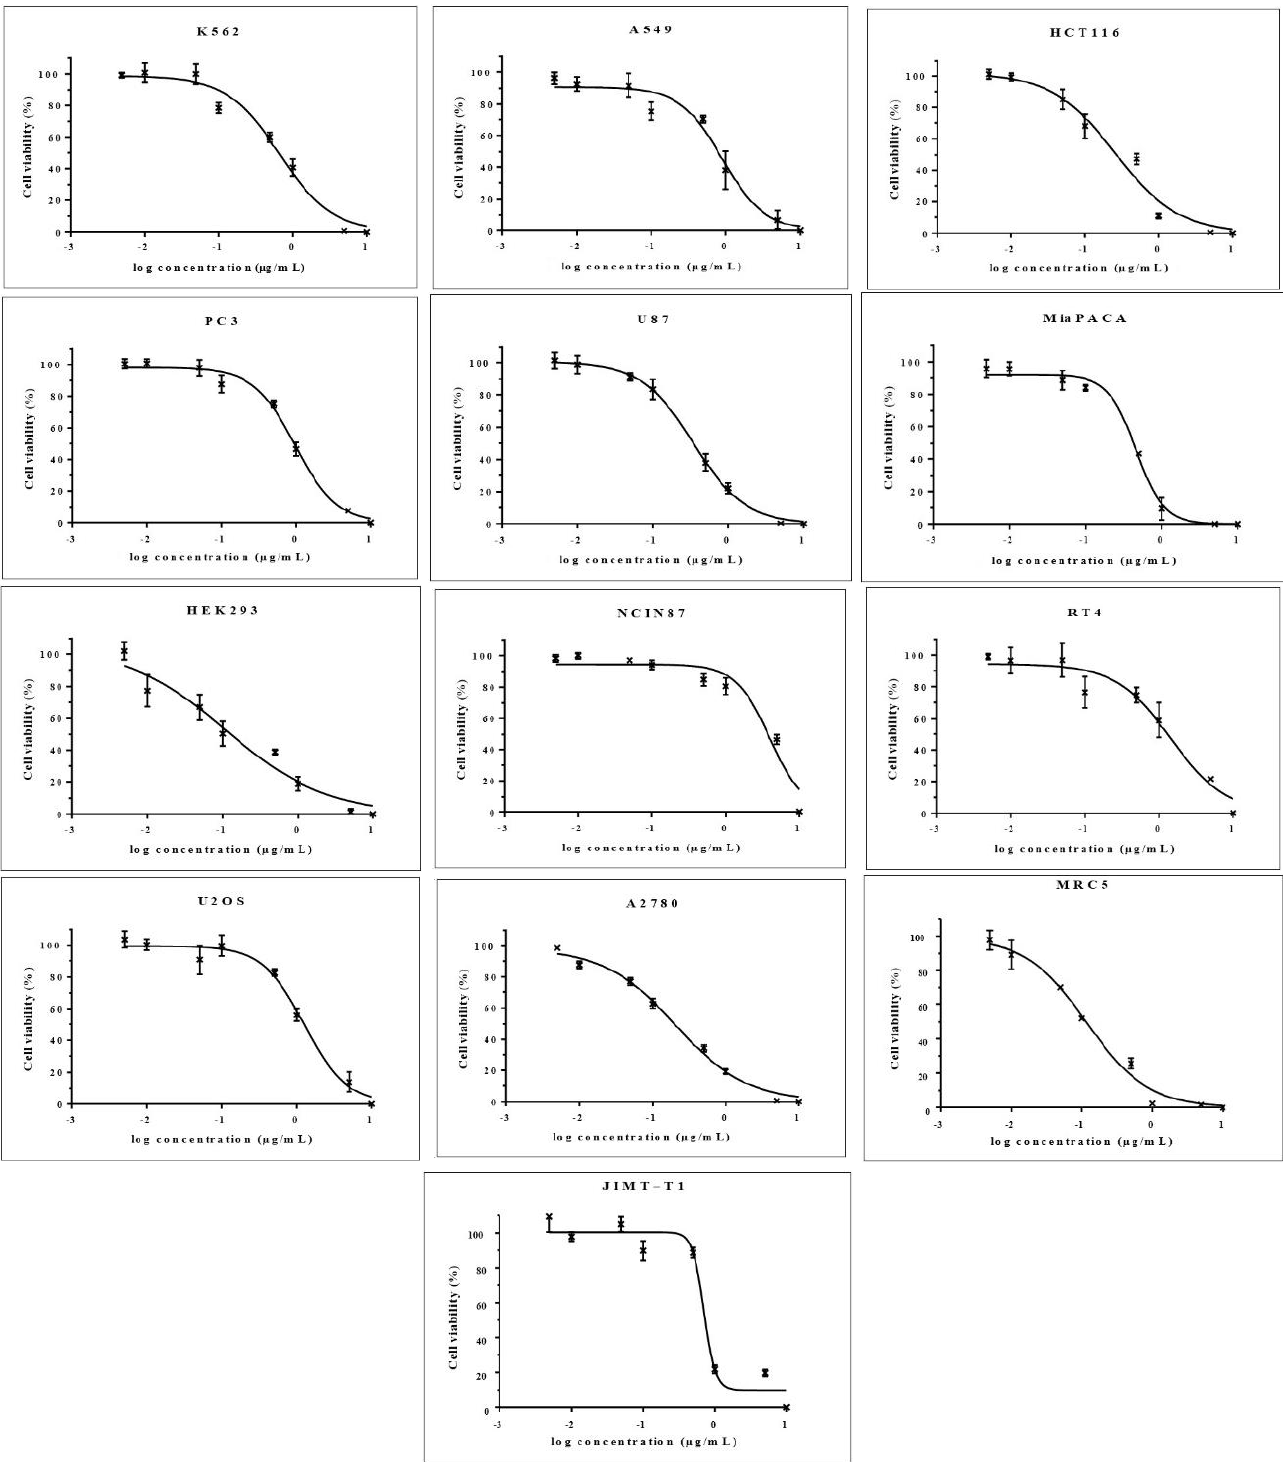
Figure 2. C ytotoxicity curves of the essential oil of Lavandula coronopifolia L. Figure 2. Cytotoxicity curves of the essential oil of Lavandula coronopifolia Table 7. IC 50 values for essential oils of Tagetes minuta L. and Lavandula coronopifolia L. Inhibition Concentration at 50% (IC50 in µg/mL)